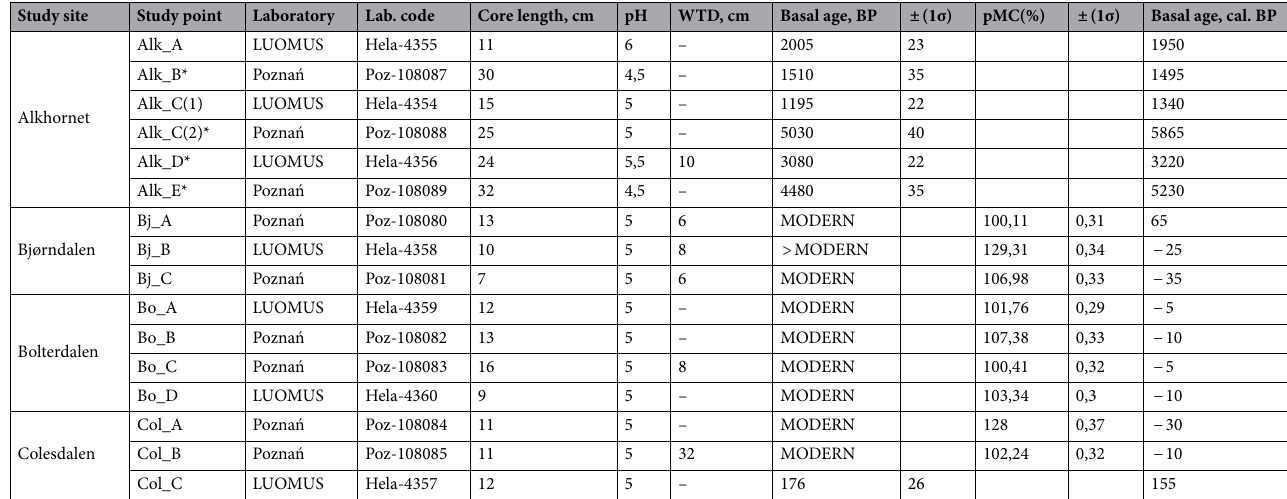
Table 2. Study site properties. For study points marked with *, core length and basal age represent depth and age down to bottom of active layer. The study point Alk_C(1) is a mid-profile sample. For water table depth (WTD), water table was not reached on study points marked with -. The calibrated basal ages were acquired from Plum age-depth